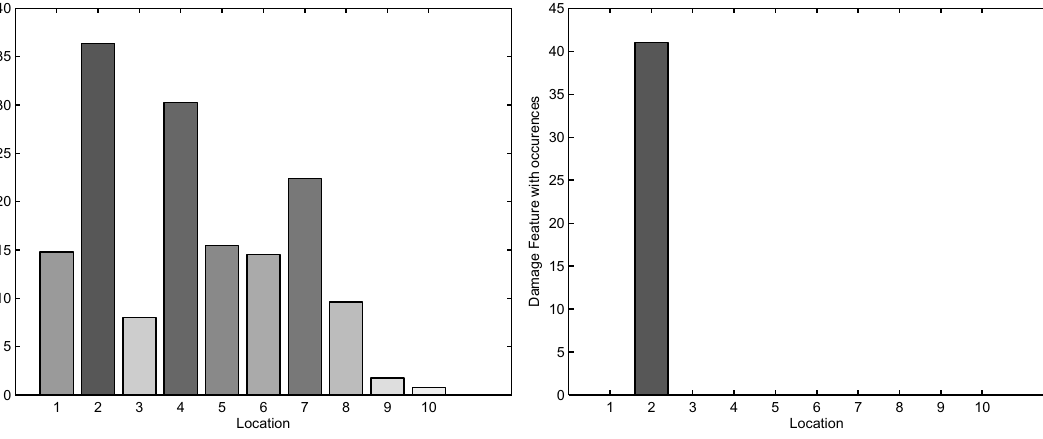
Fig. 39. Damage feature without and with occurrences for damaged structure and changing loading conditions, frequency range 90–95 Hz.